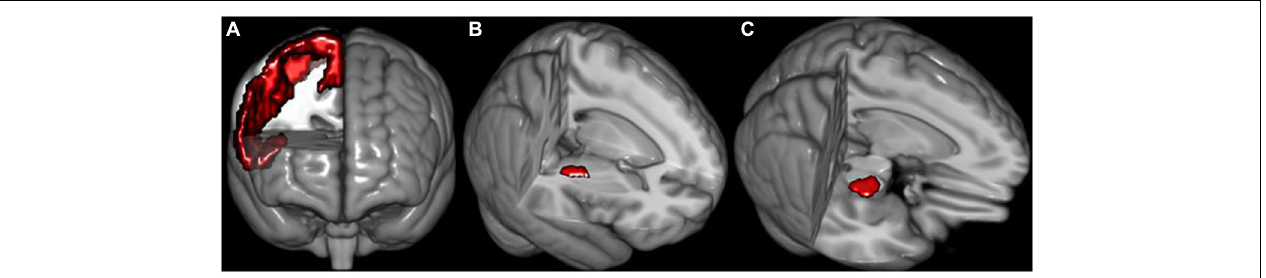
FIGURE 1 | The schematic of seeds used for fiber reconstruction. (A) Right primary motor cortex (M1). (B) Right internal capsule occipital. (C) Right anterior cerebral peduncle. The definition of seeds of the left hemisphere is similar to the right side.